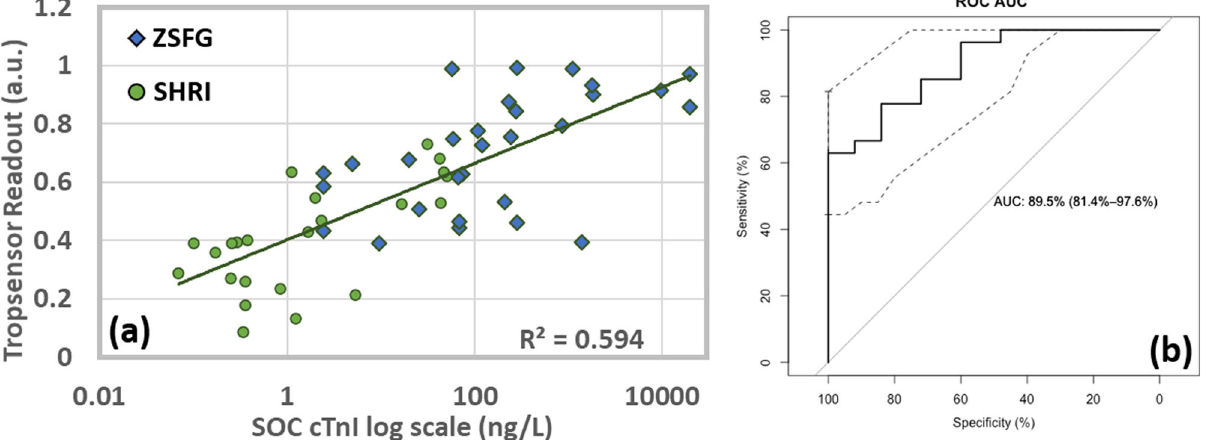
Fig. 5 Clinical validation of a high- fi delity prototype. a Correlation of the RCE sensor to plasma troponin using hs-cTnI assays ( n = 52) at 77%. SOC = standard of care. b ROC AUC plot displaying the performance of optical device output toward binary classi fi cation of elevated vs non-elevated SOC cTnI levels. AUC — 89.5%, sensitivity — 62.96% and speci fi city — 100%. (ZSFH = Zuckerberg San Francisco General, SHRI = Sengupta Hospital and Research Institute).